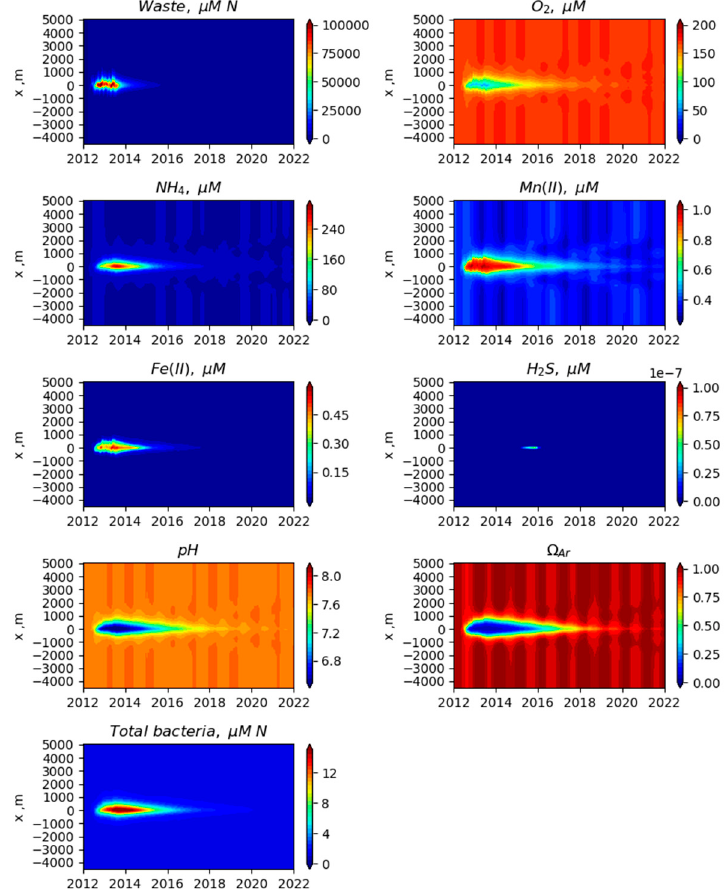
Figure 11. Temporal variability of waste, oxygen (O 2 ), ammonium (NH 4 ), Manganese(II) (Mn(II)), Iron(II) (Fe(II)), hydrogen sulfide (H 2 S), pH and aragonite saturation ( Ω Ar ), and total bacteria in the bottom layer at a transect through the fish farm.